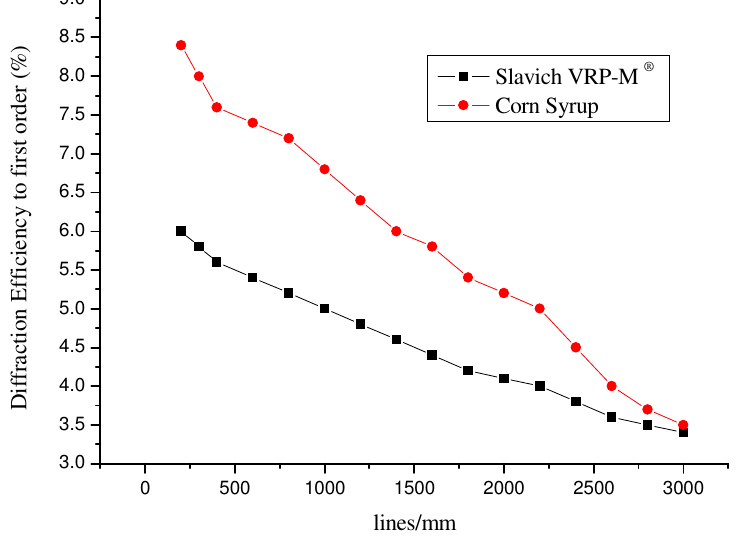
Figure 7. Behavior of spatial frequency modulation from diffraction gratings recorded in the Slavich PFG01 ® film and replication behavior in corn syrup